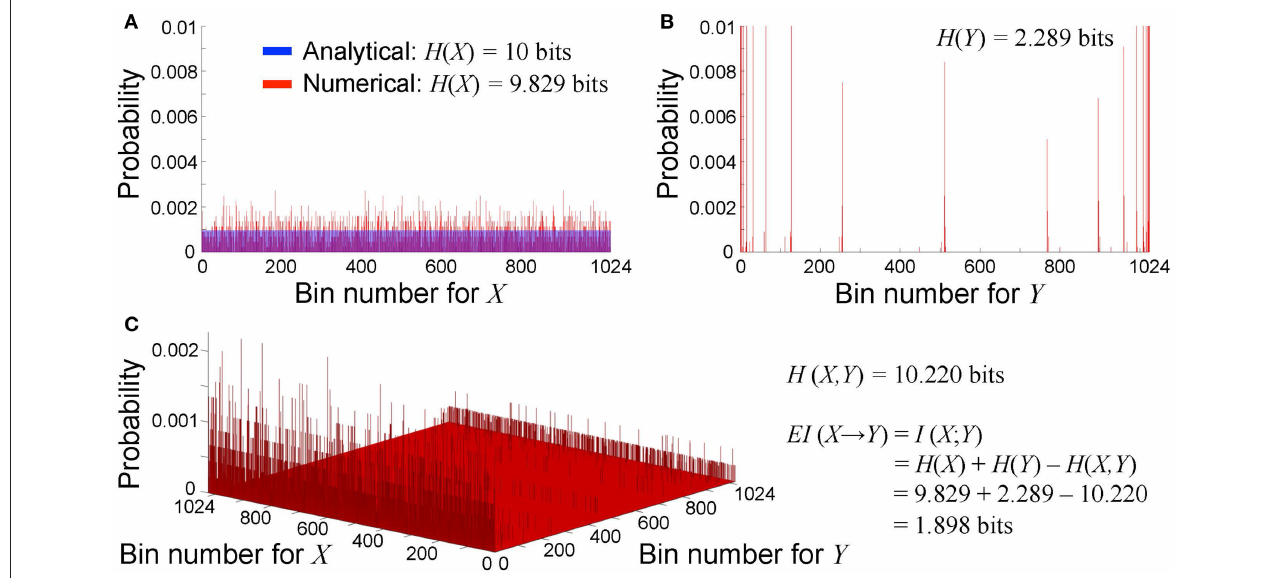
FIGURE 2 | Probability distribution of cause X and effect Y . We define the bin number b = 2 10 in this study. (A) Unconstrained probability distribution of possible cause X . Analytically, the probability of all bins is uniformly 1 / b (shown in blue), and thus entropy is equal to the maximum entropy at log 2 b =10 bits. In contrast, numerically, the probability is non-uniform due to the discretization effect (shown in red). Entropy is 9.829 bits, which close to but not identical to the maximum entropy. (B) Probability distribution of a specific state of possible effect Y . The probability is non-uniform. Entropy is 2.289 bits in this case. (C) Bivariate probability distribution of cause X and effect Y . Joint entropy is 10.220 bits in this case. Effective information from case X to effect Y is equal to mutual information between X and Y , thus is calculated as 1.898 bits.